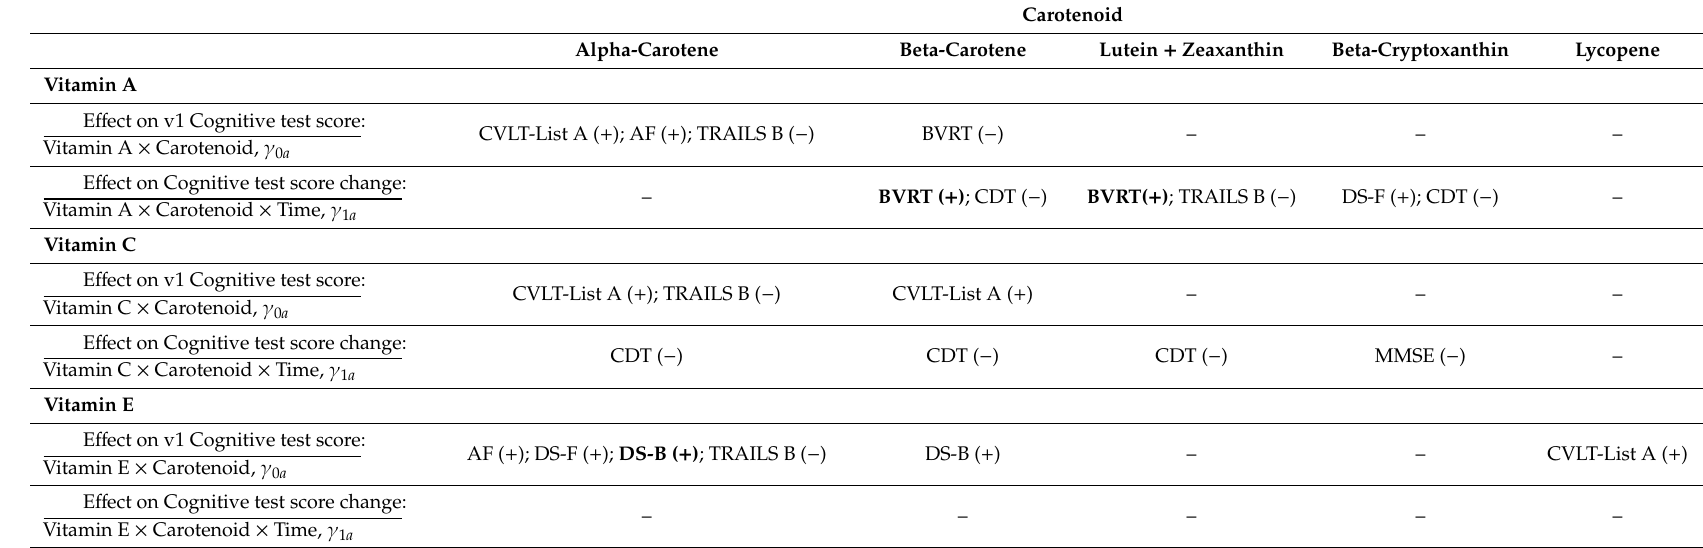
Table 3. Interactions between individual carotenoids and other antioxidants (vitamins A, E, and C) in relation to v1 cognitive test score and annual rate of change in cognitive performance: Summary of findings with p < 0.05. a,b Carotenoid Alpha-Carotene Beta-Carotene Lutein + Zeaxanthin Beta-Cryptoxanthin